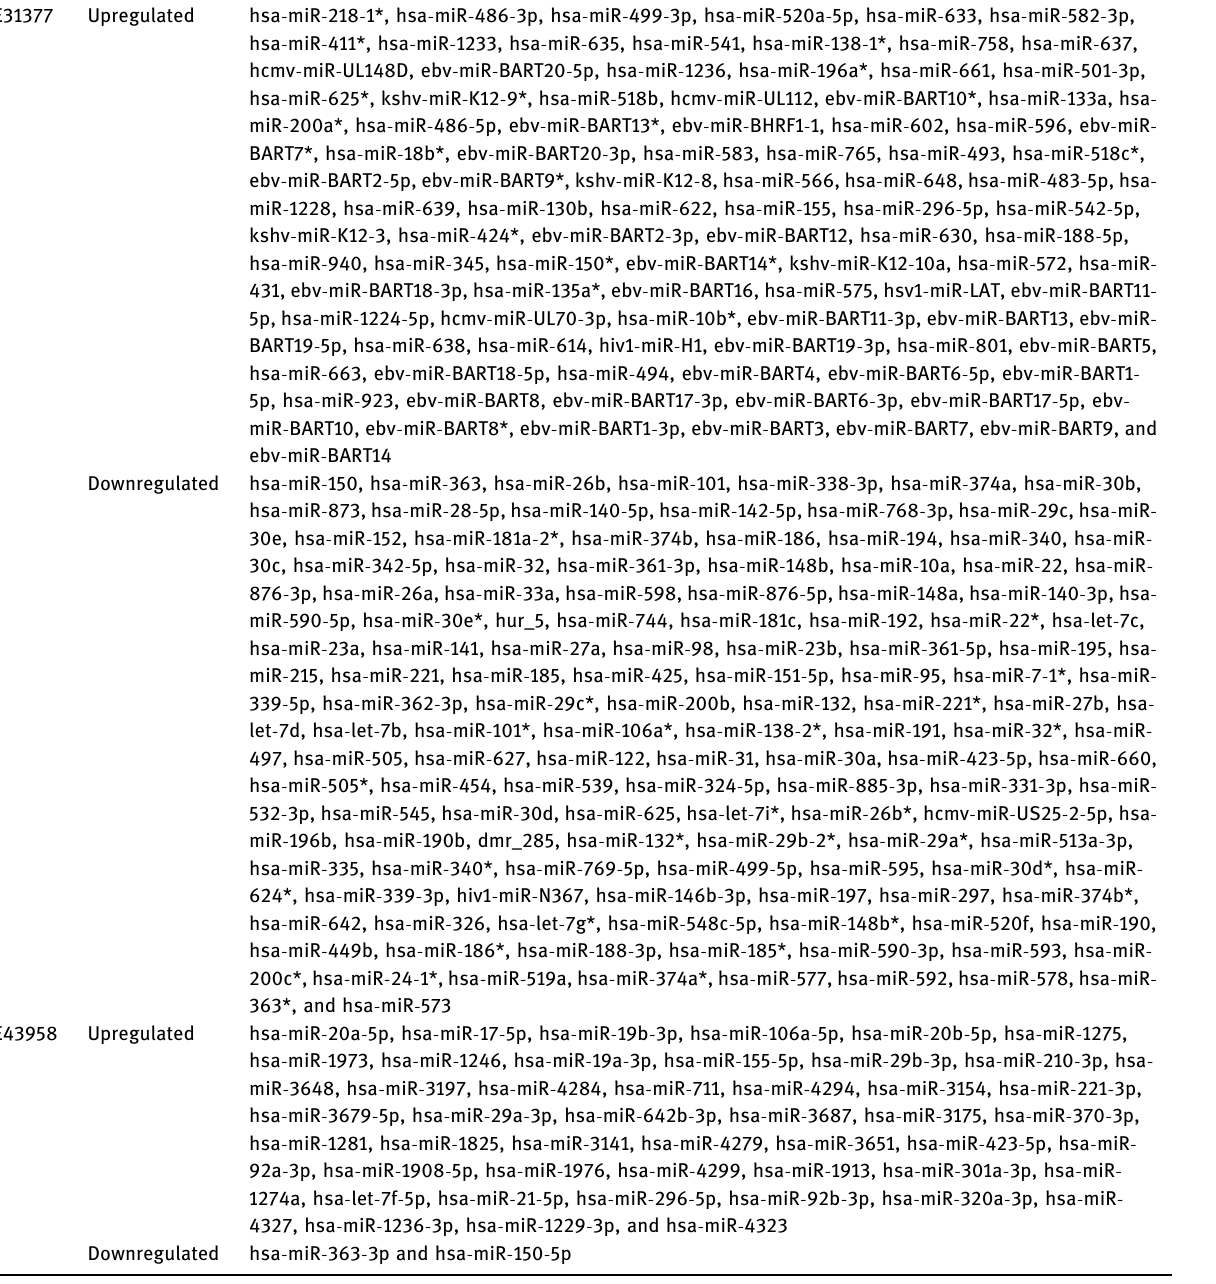
Table 2: Upregulated and downregulated miRNAs for series GSE31377 and GSE43958